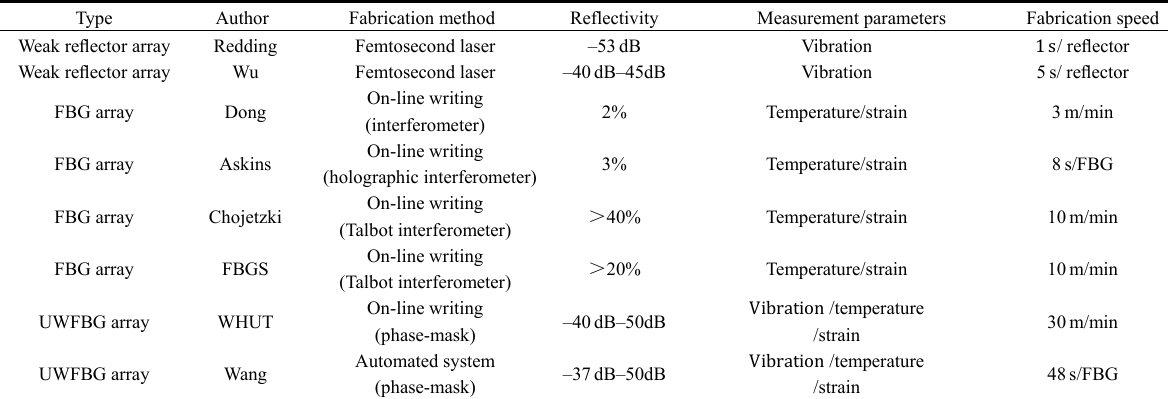
Table 1 Representative FBG array